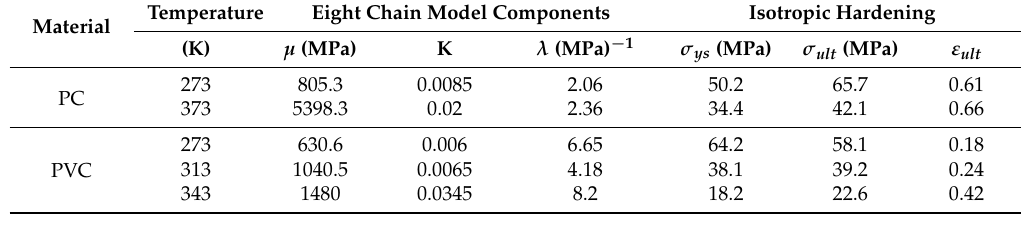
Figure 5. Experimental behavior and calibrated model results at different temperatures for PC ( a ) and PVC ( b ). Table 2. Parameters of the material model proposed.